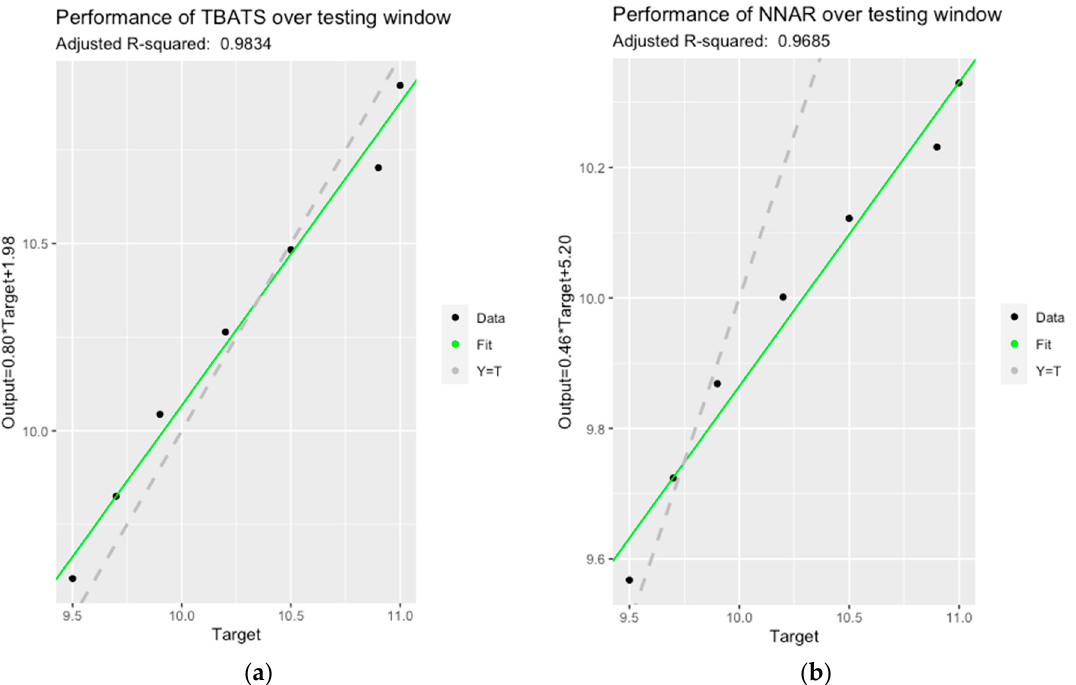
Figure 5. Model performance over testing window (e-commerce retail sales, path A): TBATS (panel a ), and NNAR (panel b ). Source: estimation results.